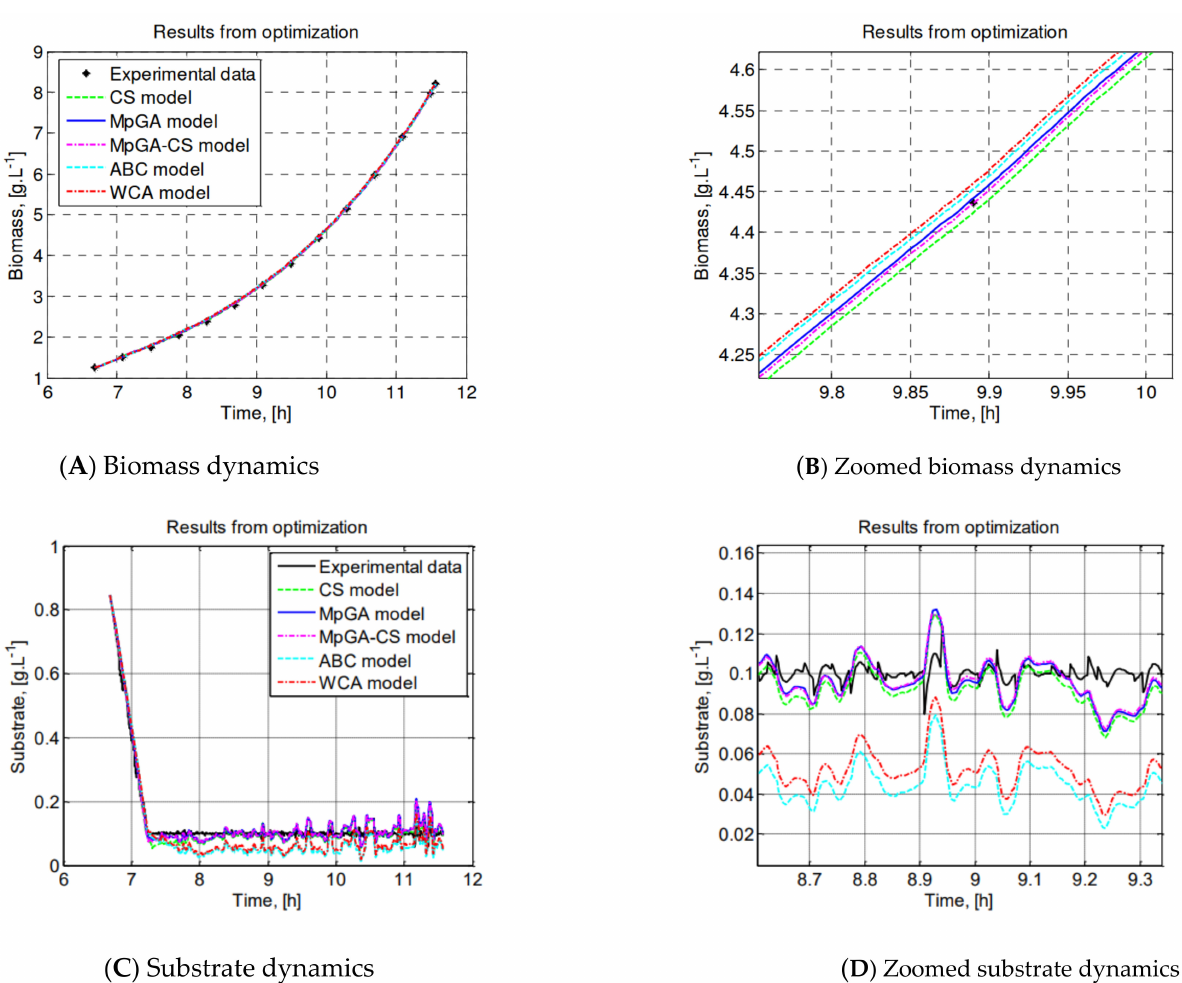
Figure 3. Graphical comparison of the results from parameter identification of E. coli FP